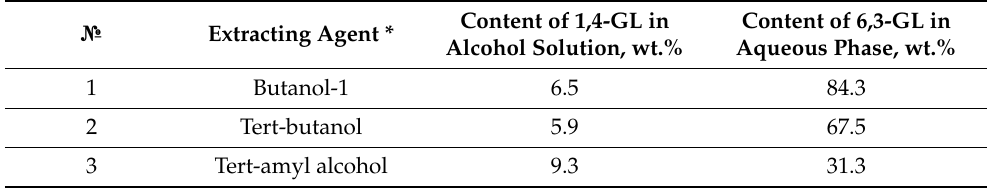
Table 3. Extraction of individual glucarolactones.